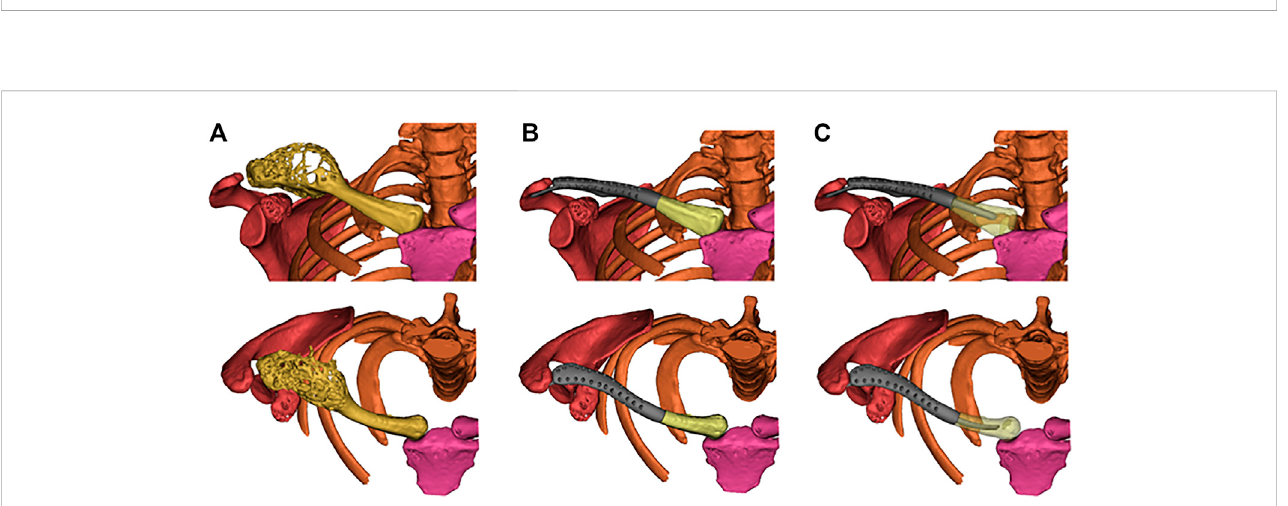
FIGURE 2 Preoperative image data of the patient. (A) Anteroposterior X-ray of the right clavicle showing an large and expansive lesion (Red Arrow), with another lesion involving coracoid process (Blue Arrow). (B , C) Computed tomography (CT) images showing osteolytic lesions with cortex-destructing. Magnetic resonance imaging showing the expansive lump with isointensity to muscle on a (D) T1-weighted image and homogeneous hyperintensity on a T2-weighted image (E) . (F) 3D model of the shoulder reconstructed from CT scans.